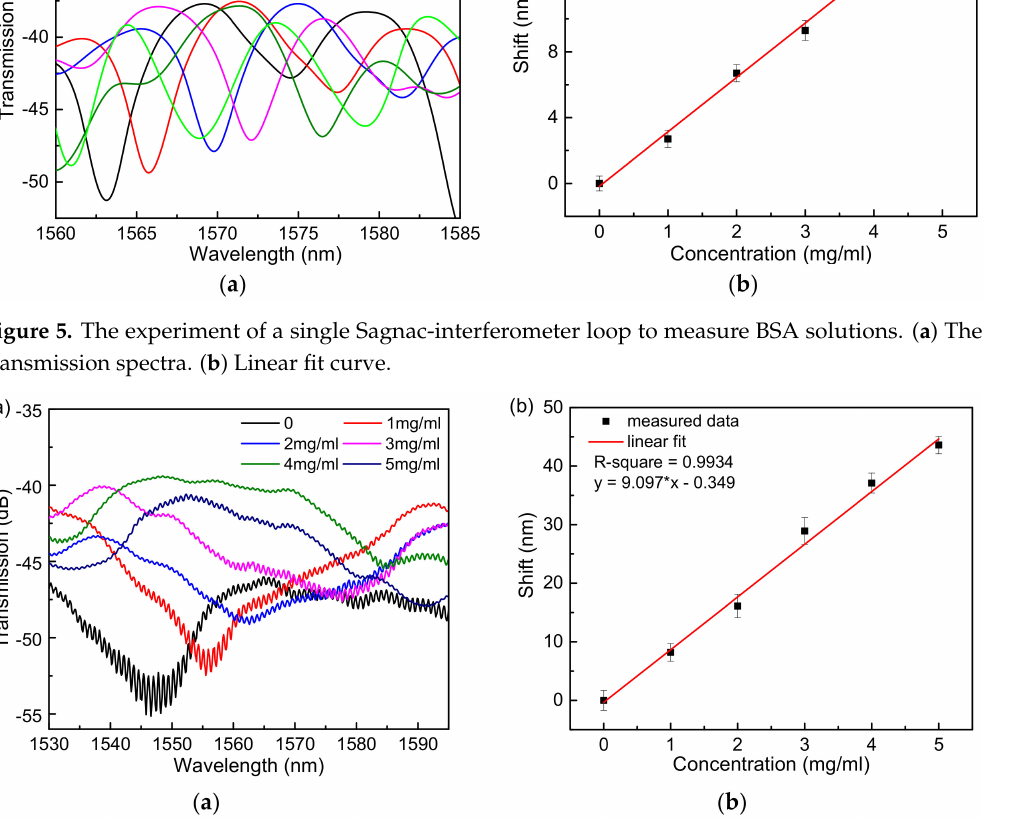
Figure 6. The experiment of the cascaded Sagnac-interferometer loop to measure BSA solutions. ( a ) The transmission spectra. ( b ) Linear fit